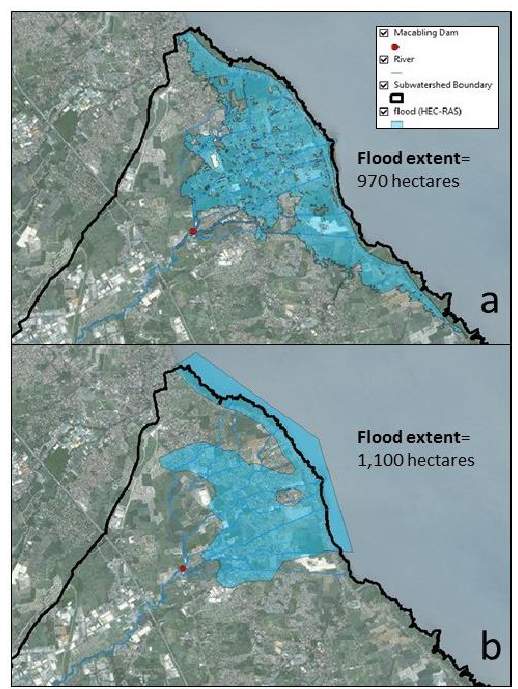
Figure 11. Flood extent map using the 2D unsteady flow analysis (a) and MGB susceptibility map (b)